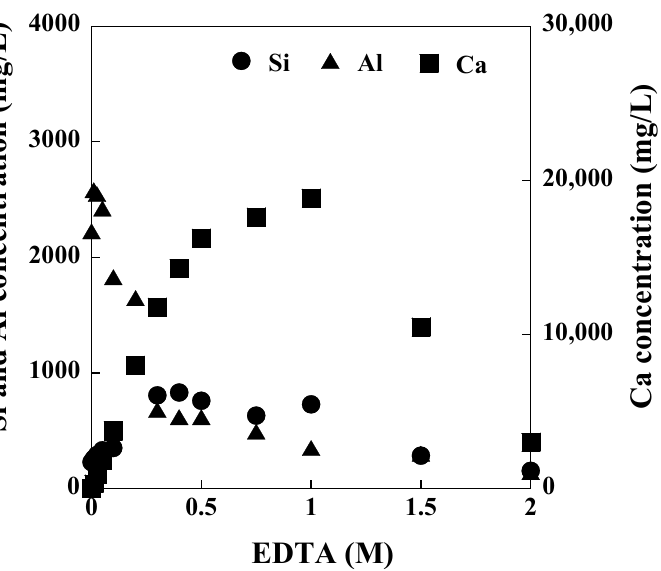
Figure 2. Concentrations of Si, Al, and Ca in the solution after synthesis with various concentrations of added EDTA (NaOH concentration: 3 M NaOH, Temperature: 80 °C, Reaction time: 24 h).